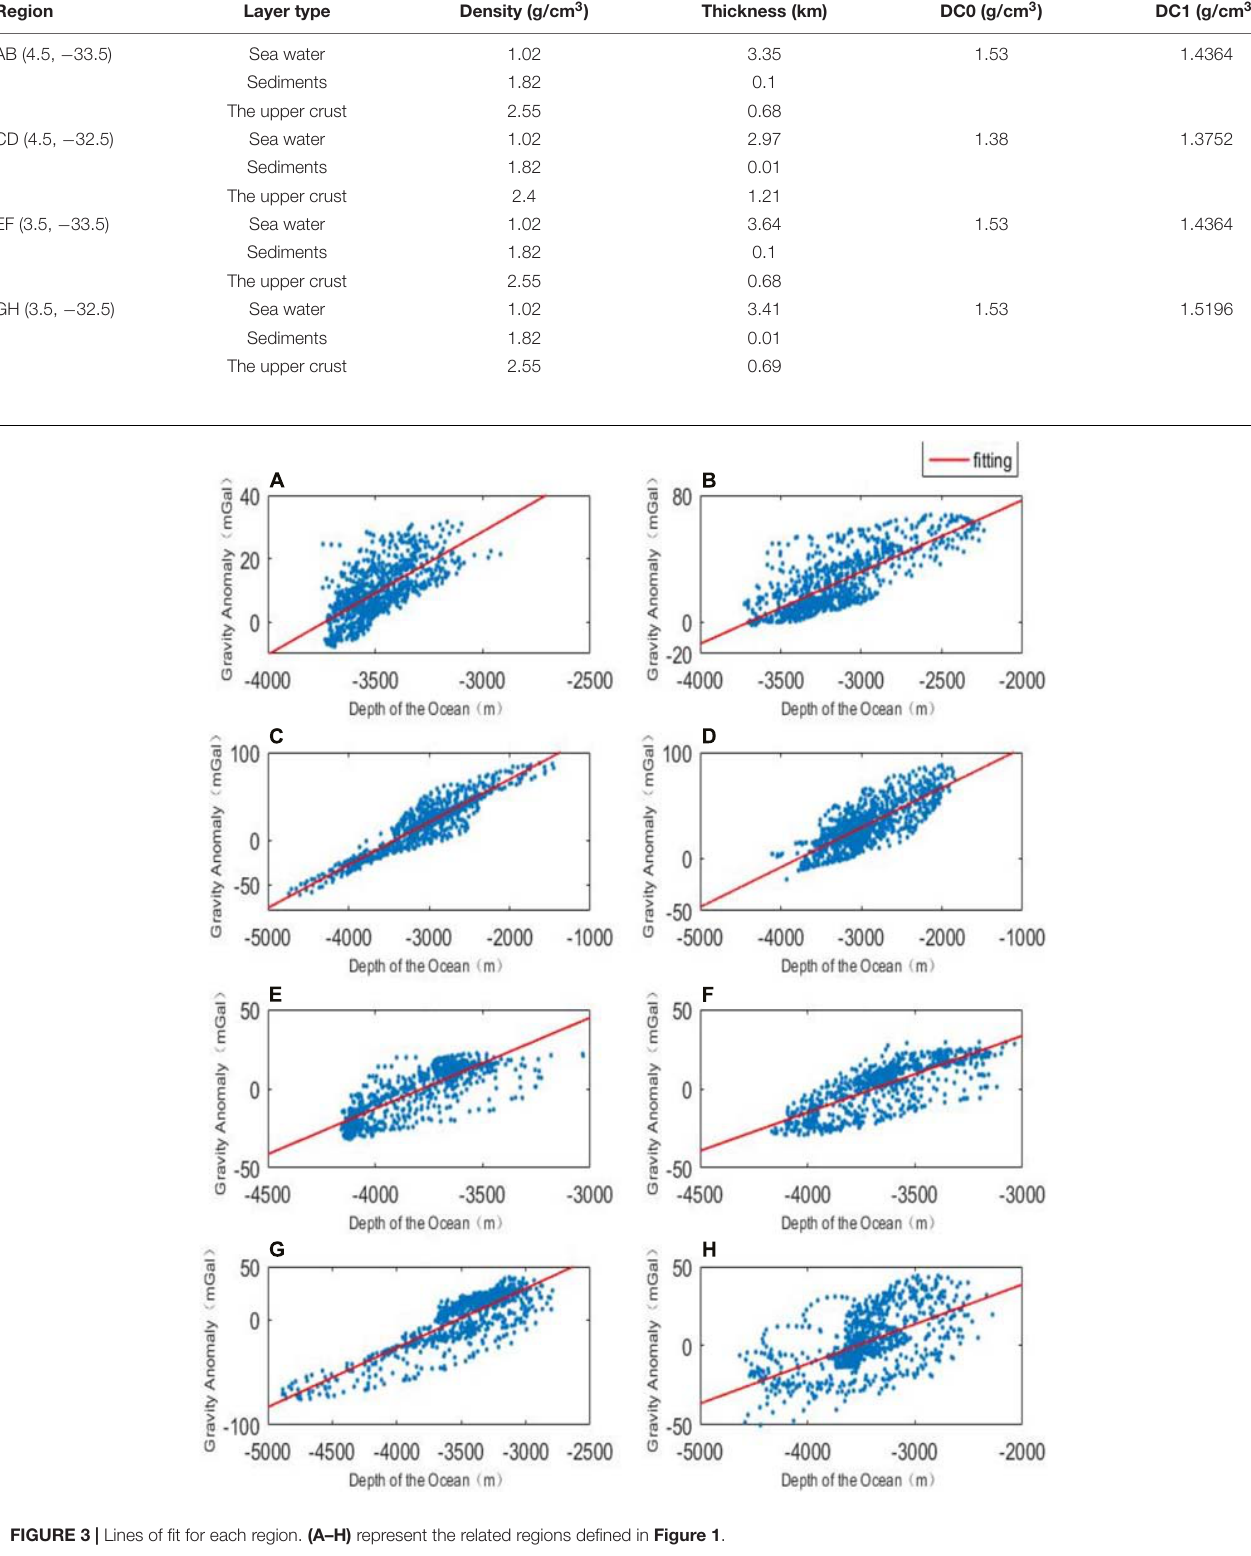
Frontiers in Earth Science |